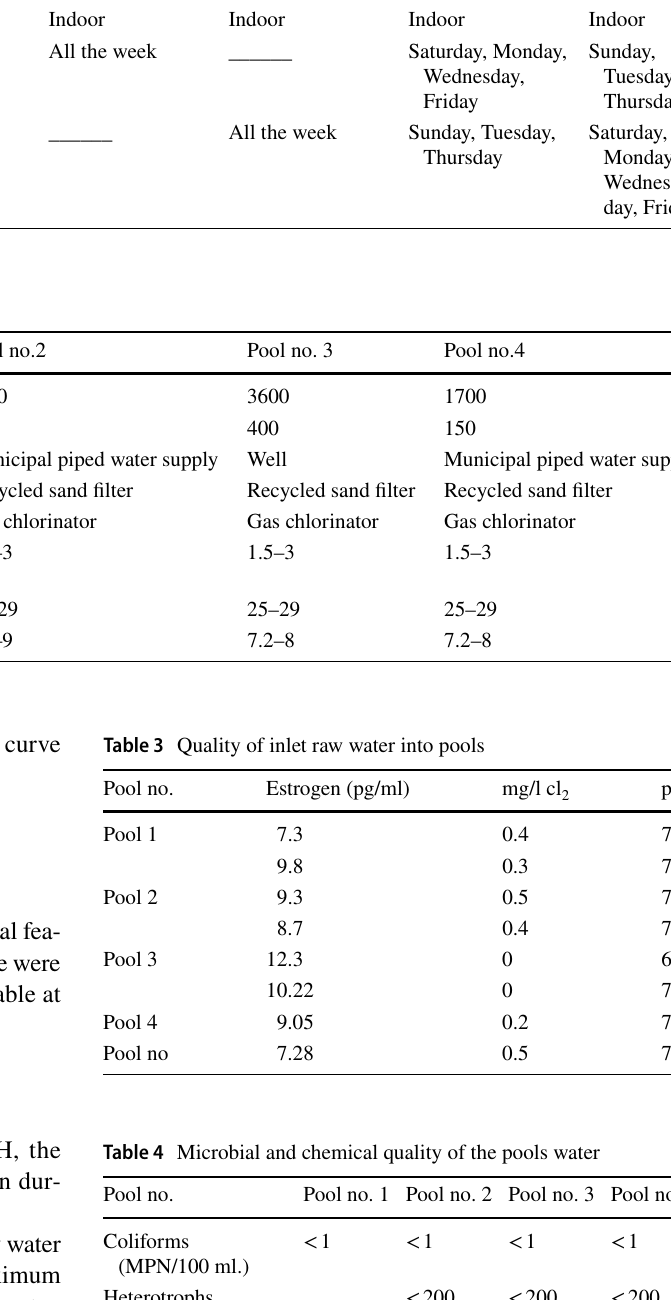
Table 1 Features of pools according to sexuality